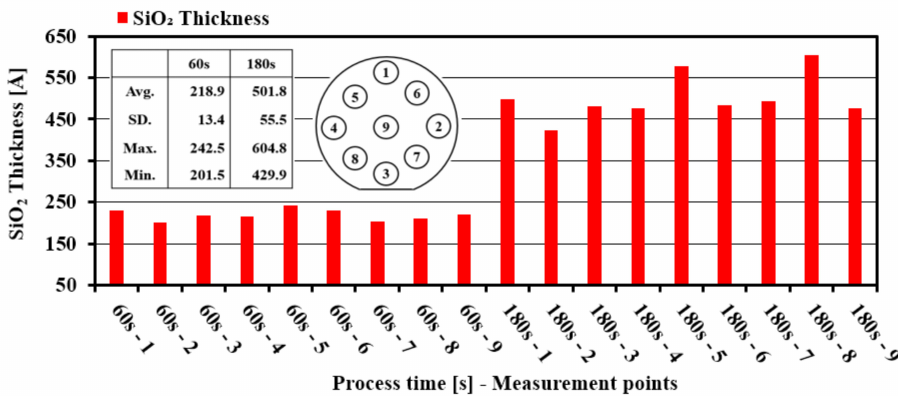
Figure 10. Deposition thickness changes in SiO 2 at different process